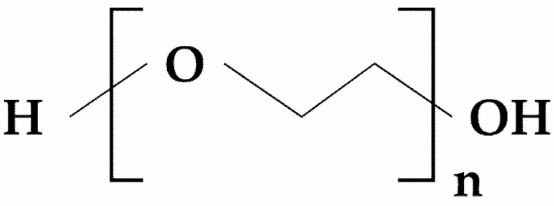
Figure 11. Chemical structure of polyethylene oxide.